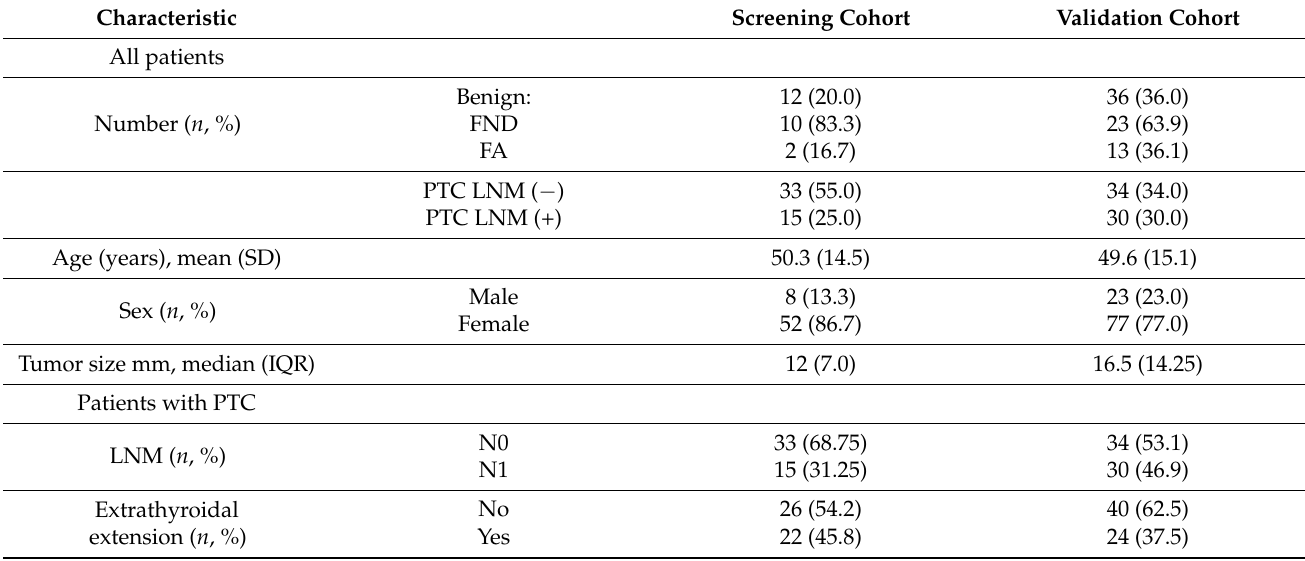
Table 2. Clinical-demographic characteristics of the study